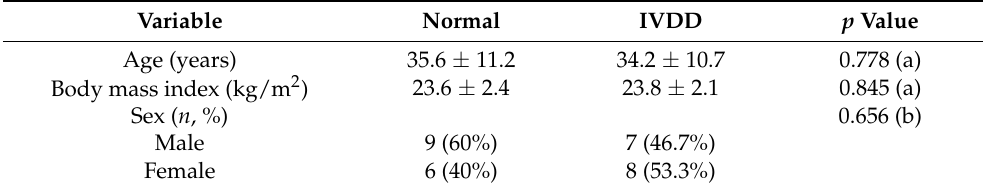
Table 1. The characteristics of the patients.